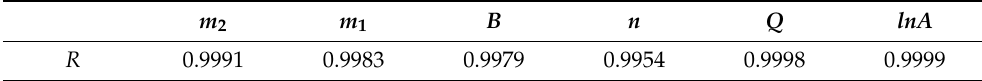
Table 7. Fitting correlation coefficient of the constitutive equation.